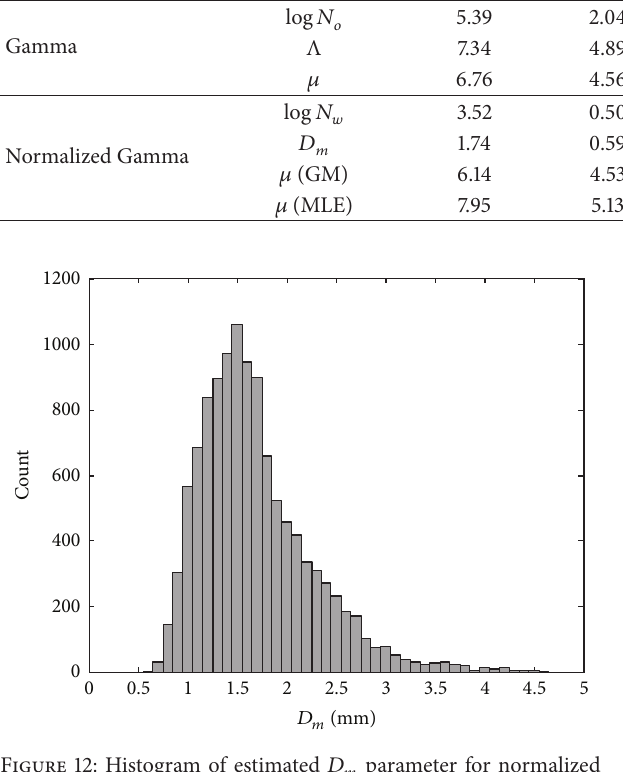
Figure 12: Histogram of estimated 𝐷 𝑚 parameter for normalized Gamma model.